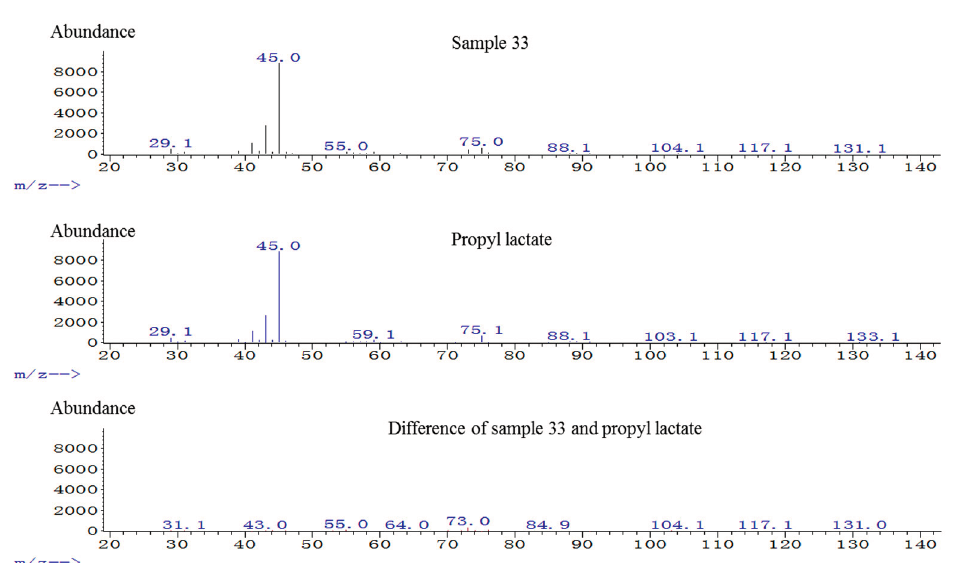
Figure 1. TIC of propyl lactate in GC-MS. The mass spectra of an unknown compound shown at 17.4 min in sample 33 and propyl lactate standard are presented. The differential spectrum of them is located at the bottom.